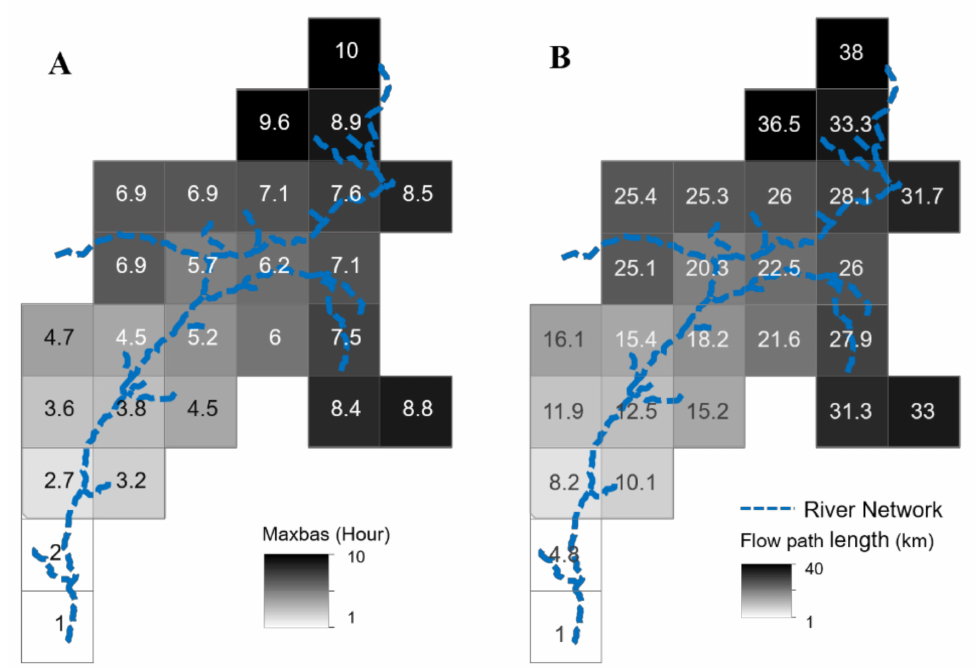
Figure 4. ( A ) Flow path length input to the FW-1 model, and ( B ) the model Maxbas values calculated for each